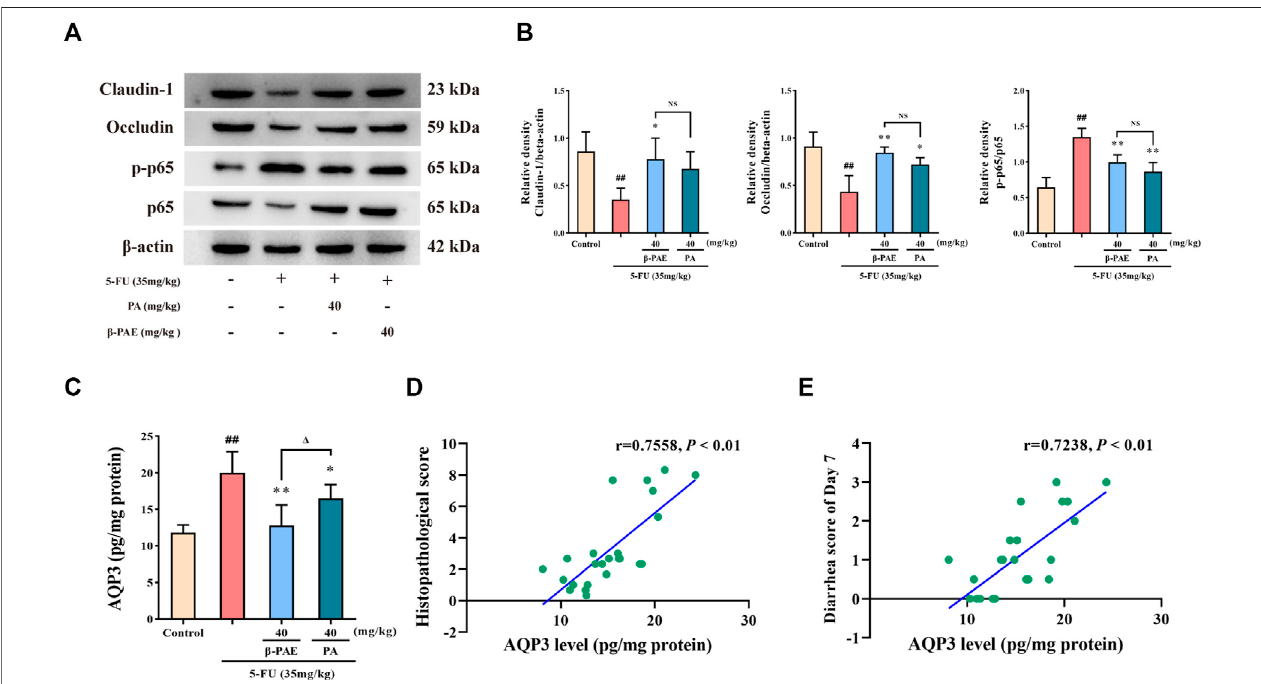
FIGURE 9 | Comparative study of the effects of β -PAE and PA on the epithelial barrier, in fl ammatory response, and water transport. (A,B) Claudin-1, occludin, p-p65andp65expression; (C) AQP3expression; (D) SpearmancorrelationanalysisbetweenAQP3levelandhistopathologicalscore; (E) Spearmancorrelationanalysis between AQP3 level and diarrhea scores on Day 7. Data are shown as mean ± SD ( n (cid:2) 3 – 6). ## p < 0.01 versus control group; * p < 0.05, ** p < 0.01 versus 5-FU group; Δ p < 0.05 versus PA group. NS: not statistically signi fi